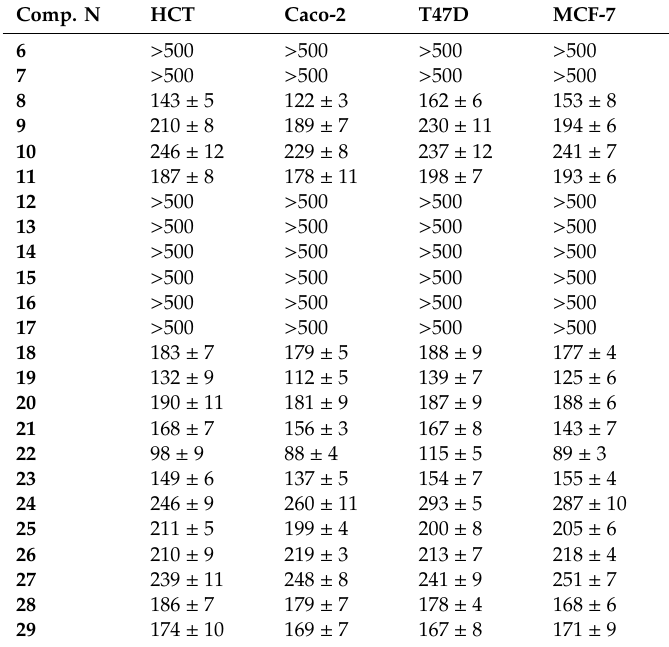
Table 4. Growth inhibition IC 50 ( µ M) of HCT-116 and T47D cell lines after 48 h exposure time. Data are expressed as mean ± SD of three independent experiments. Comp.